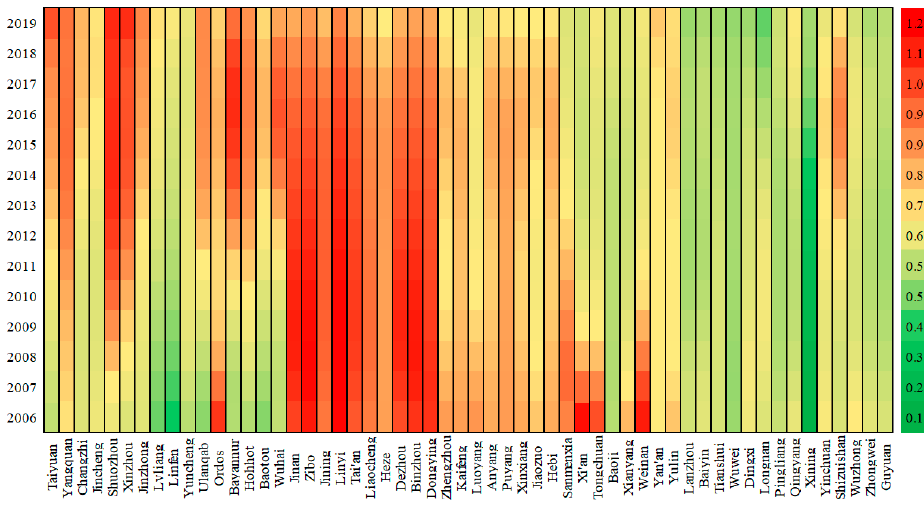
Figure 2. Heat Map of population coefficient.